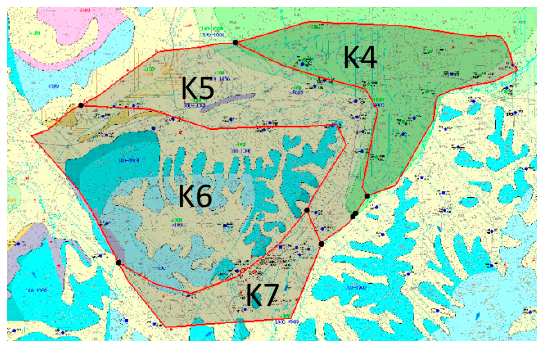
Figure 4. Parameter zoning map of the confined aquifer.